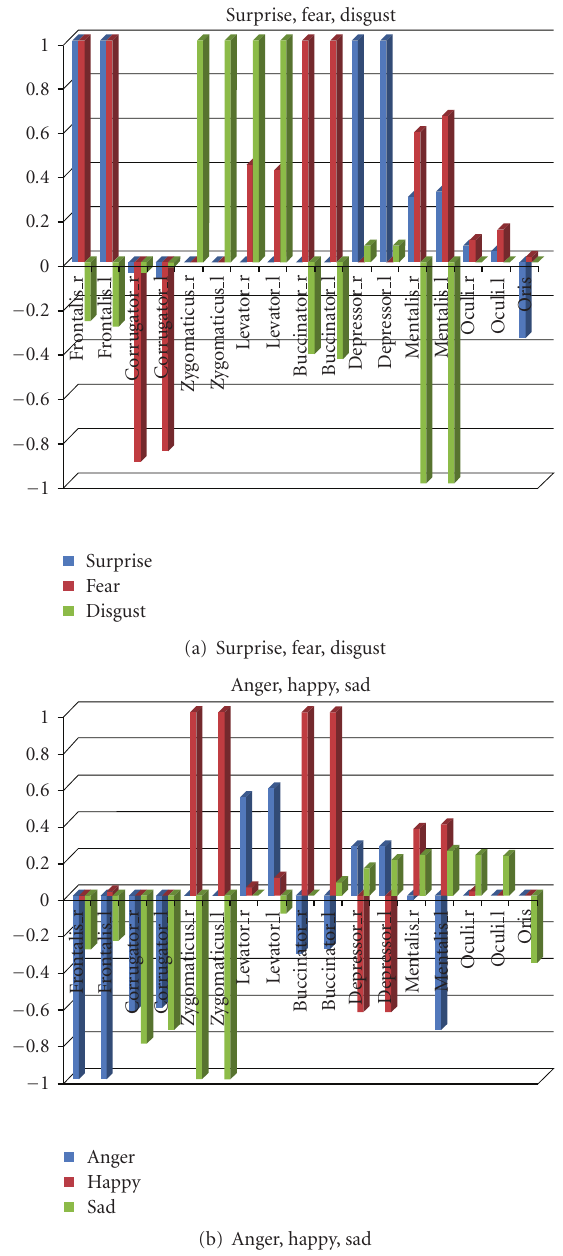
Figure 11: Amounts of muscle contraction for each expression. If the amount is positive, the muscle stretches and if negative the muscle